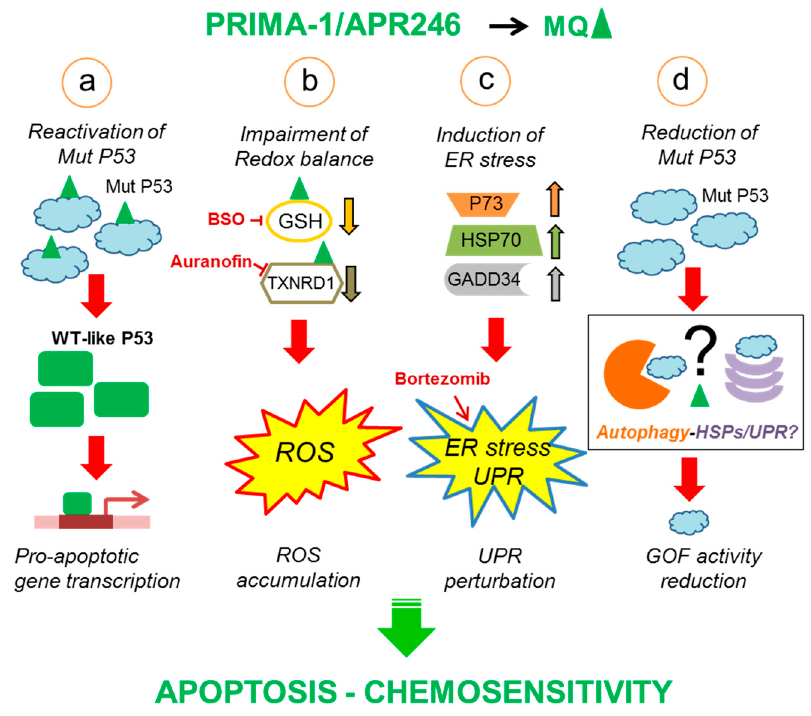
Figure 1. PRIMA-1/APR246 activities reported in hematological tumor cells. The main activities of PRIMA-1/APR246 leading to apoptosis induction and cell death are depicted: ( a ) the reactivation of mutant P53, leading to the expression of P53 target genes and apoptosis induction; ( b ) the perturbation of redox balance mediated by a reduction of GSH level and TXNRD1 activity due to direct binding of the PRIMA-1/APR246 reactive compound MQ; molecules that can further impair GSH and TXNRD1 activity (BSO and Auranofin, respectively) are indicated; ( c ) the induction of ER stress and UPR mediated by upregulation of HSP70, GADD34, and P73; bortezomib able to enhance the UPR and synergize with APR246 to increase tumor cell death is indicated; ( d ) the reduction of mutant P53 levels through unknown pathways (black box) that may result in the decrease of mutant P53 GOF activity. ROS, reactive oxygen species; HSPs, heat shock proteins; UPR, unfolded protein response; ER, endoplasmic reticulum; Mut P53 (mutant P53); WT (wild-type).